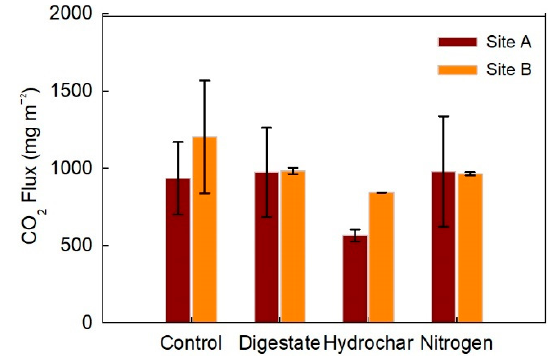
Figure 4. Cumulative CO 2 fluxes in mg m − 2 from subplots in sites A and B treated with digestate, hydrochar, urea (nitrogen), and control treatments from June–October 2018. Values are a mean of two replicated plots with error bars representing the standard error.